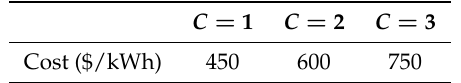
Table 3. Utility-Scale lithium-ion battery investment